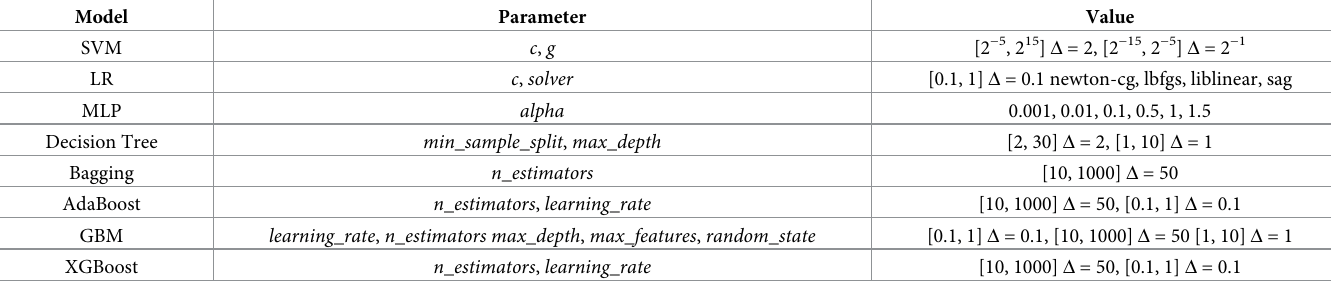
Table 4. Parameters and the value range of parameter